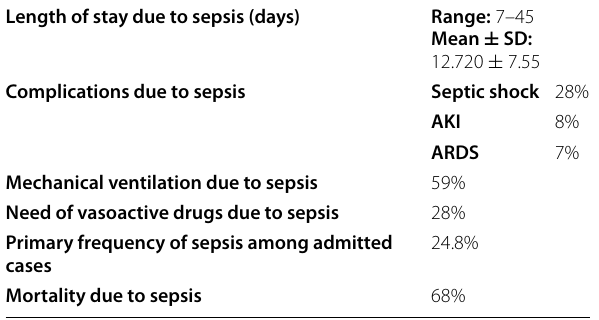
Table 3 Measured outcomes among sepsis cases